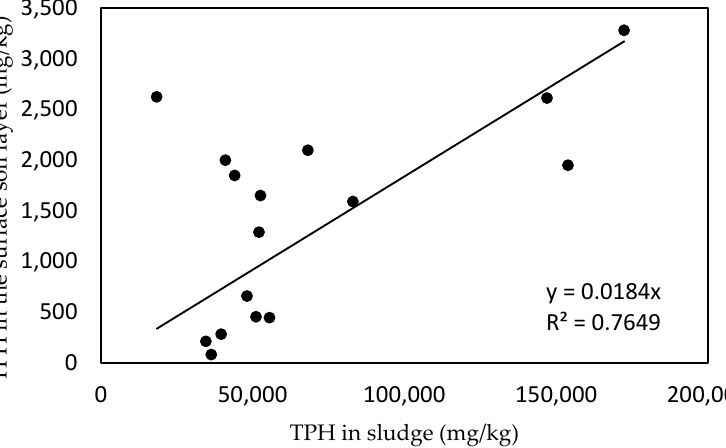
Figure 6. TPH relationship between the sludge and the underlying surface soil layer.